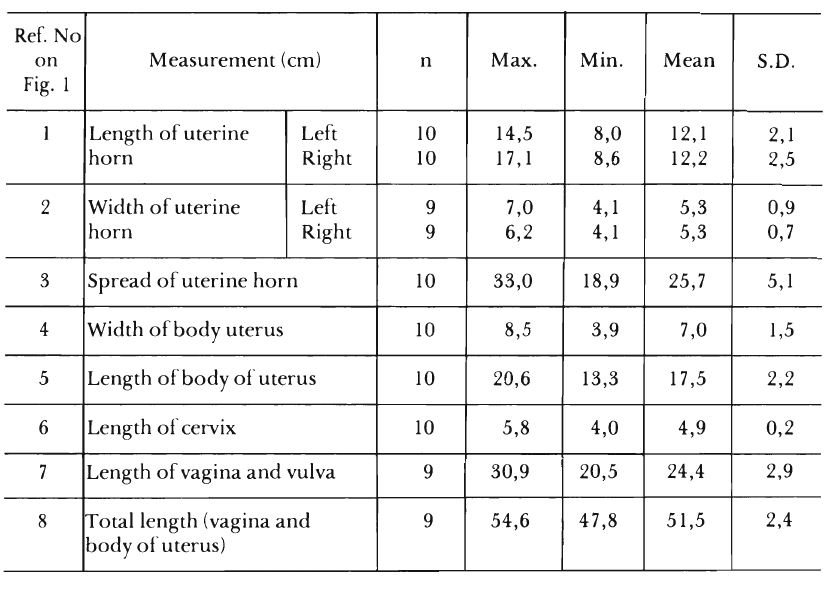
Uterine and vaginal dimensions for adult Burchell's z.ebra mares collected in the Central District of the Kruger National Park